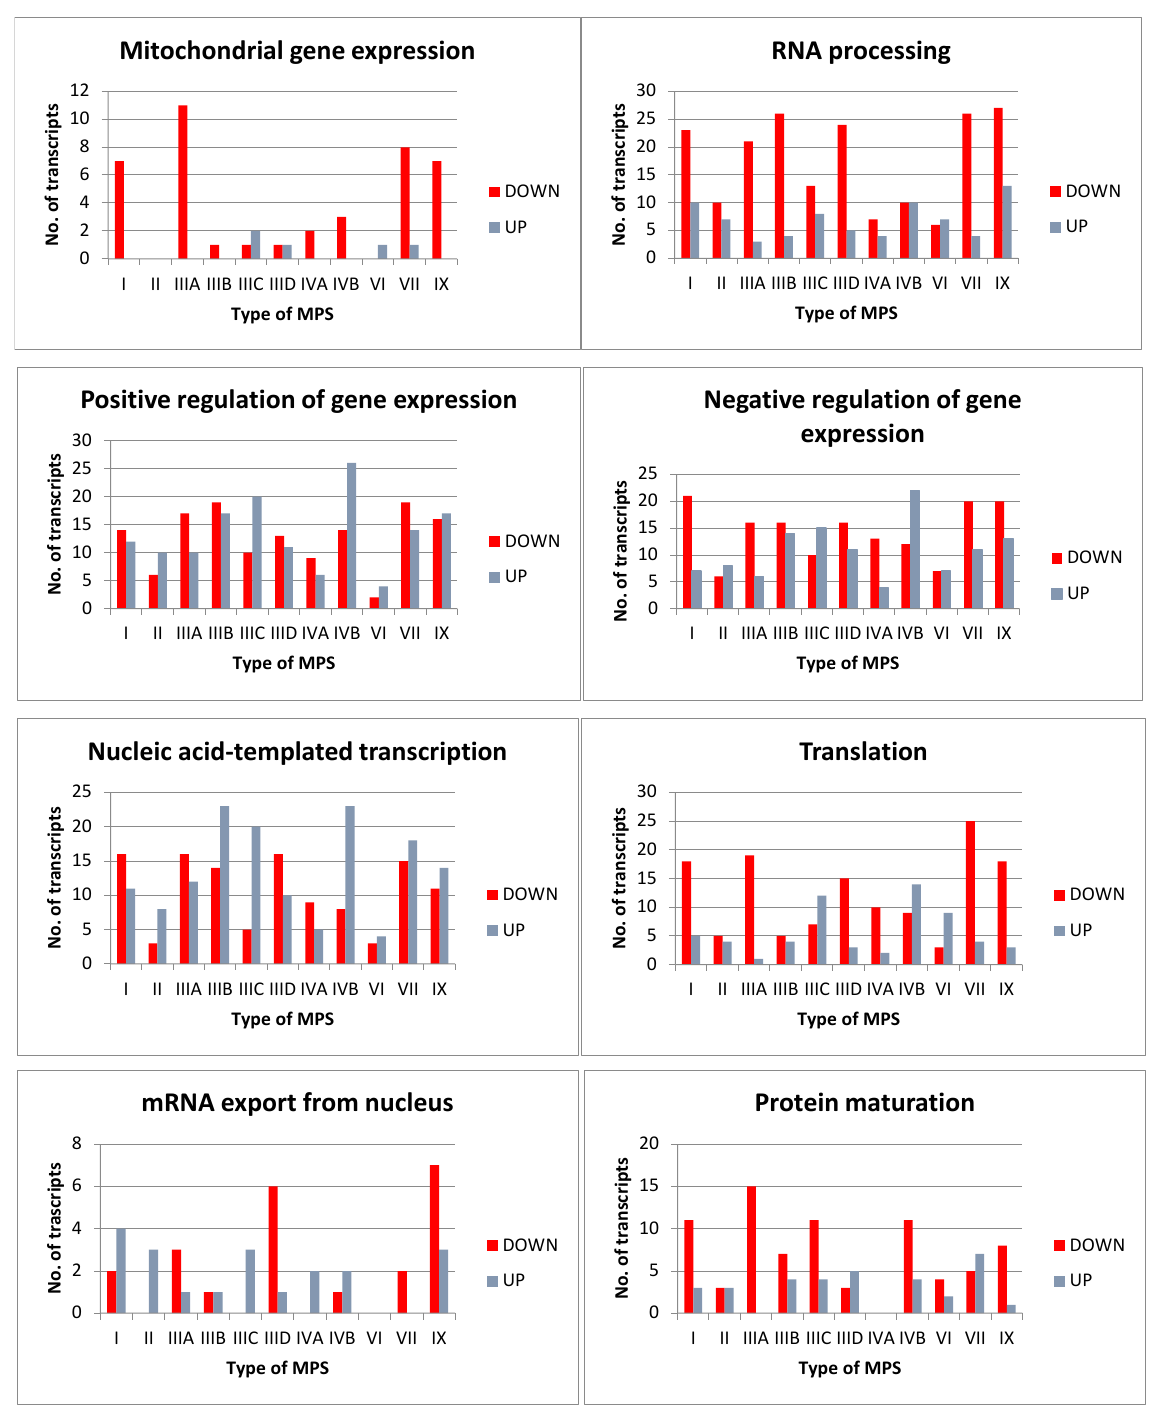
Figure 3. Number of transcripts of genes with changed levels (at FDR < 0.1; p < 0.1) in different types